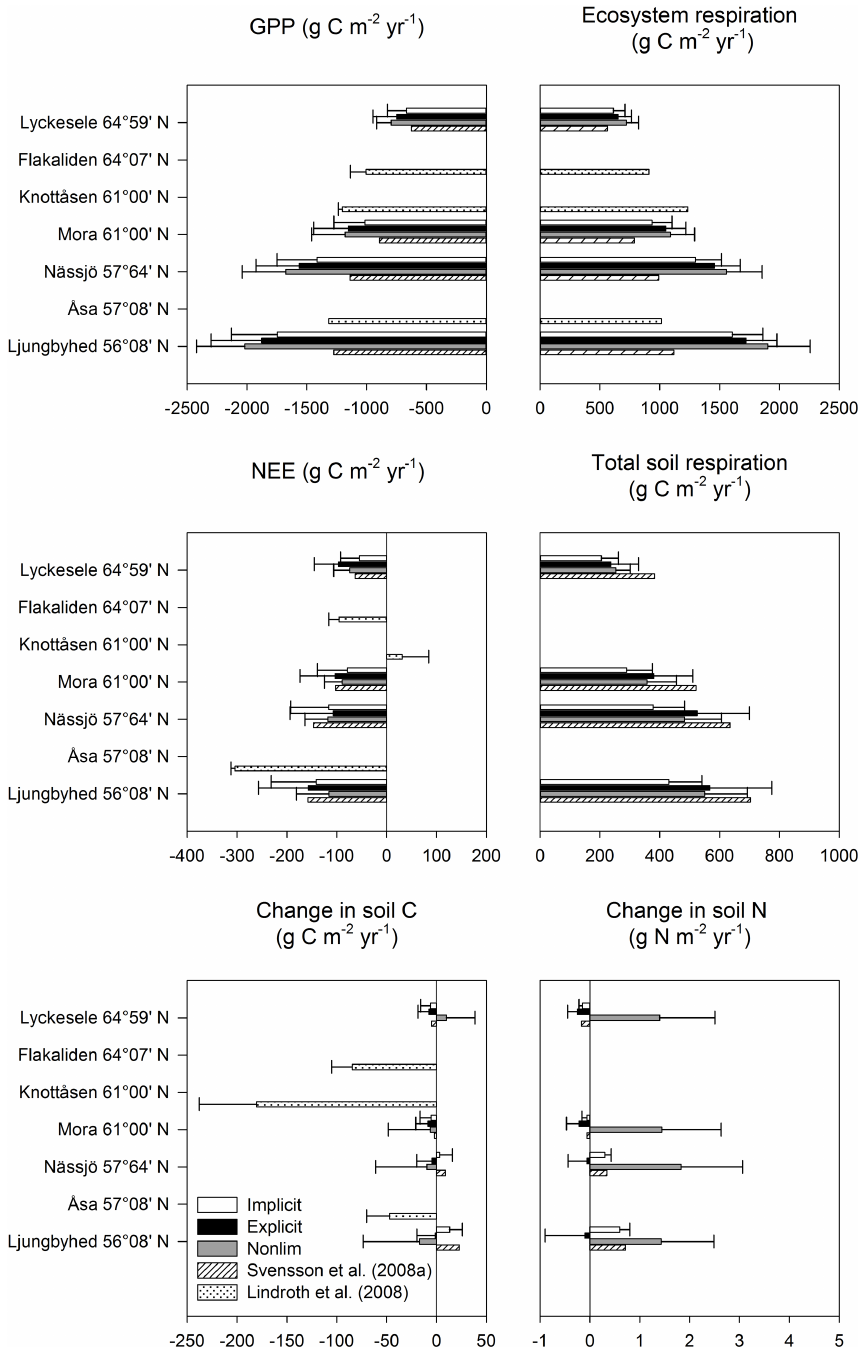
Figure 5. Simulated GPP, ecosystem respiration, NEE, soil respiration, change in soil C, and change in soil N for all four sites with the three ECM modeling approaches and also compared with modeled data by Svensson et al. (2008a) and measurements by Lindroth et al. (2008).